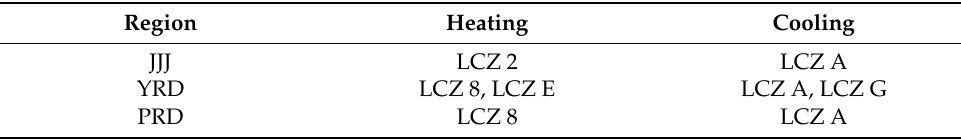
Figure 7. Departure of each LCZ type from the region’s mean LST in summer daytime in JJJ (a), YRD (b) and PRD (c). ( b ) and PRD ( c ). Table 5. The dominant LCZ types in summer daytime, 2018. Table 5. The dominant LCZ types in summer daytime,